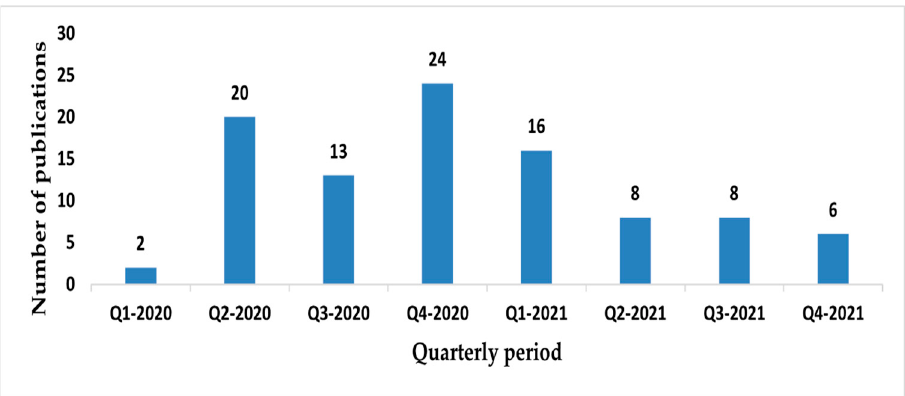
Figure 6. Published studies for each quarterly period, between January 2020 to December 2021.